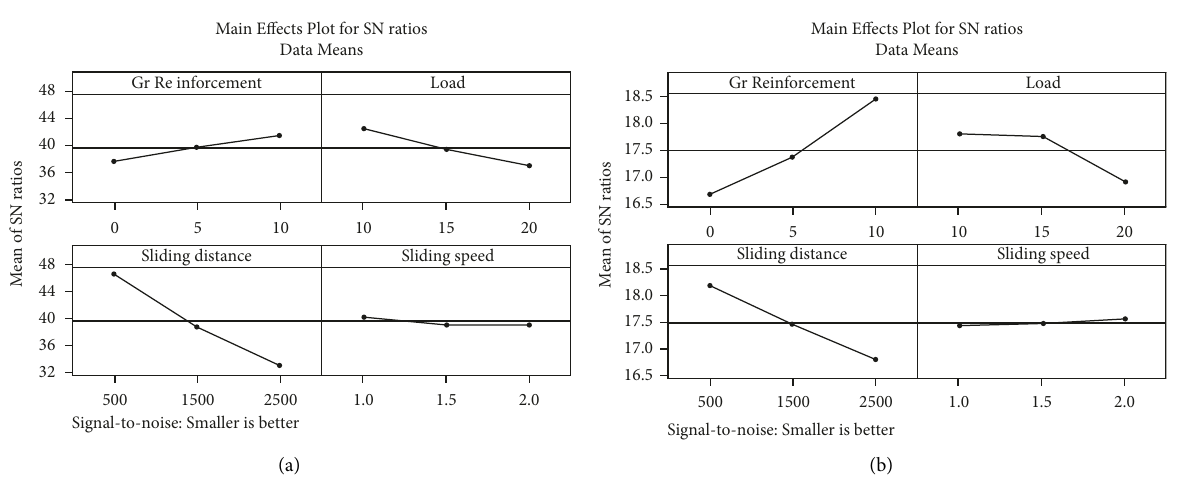
Figure 4: Main effects plot. (a) Wear loss of aluminum with a mixture of SiC and Gr hybrid nanocomposites. (b) Coefficient of friction with a blend of SiC and Gr hybrid